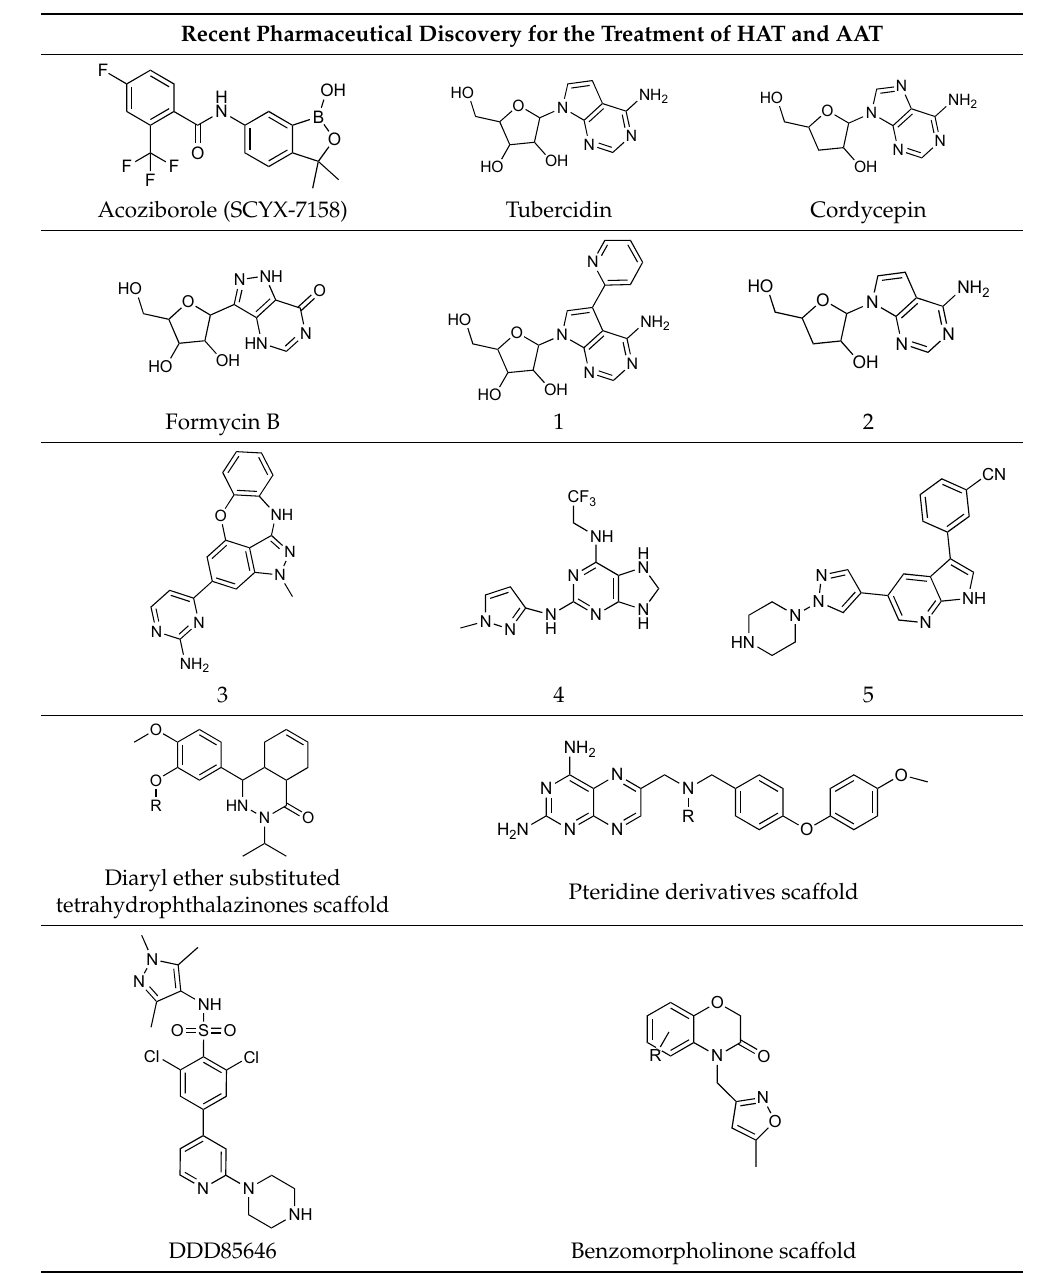
Table 4. Recent pharmaceutical discoveries against African Trypanosomiasis (HAT and AAT). Recent Pharmaceutical Discovery for the Treatment of HAT and AAT